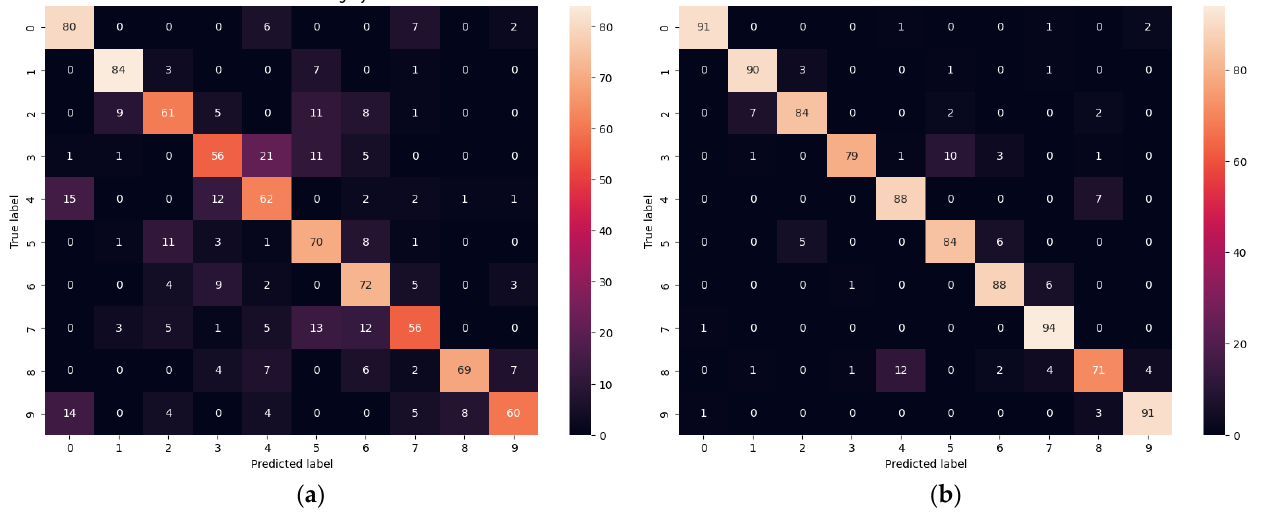
Figure 15. Confusion matrixes for test set of grayscale ( a ) and RGB ( b ) images.